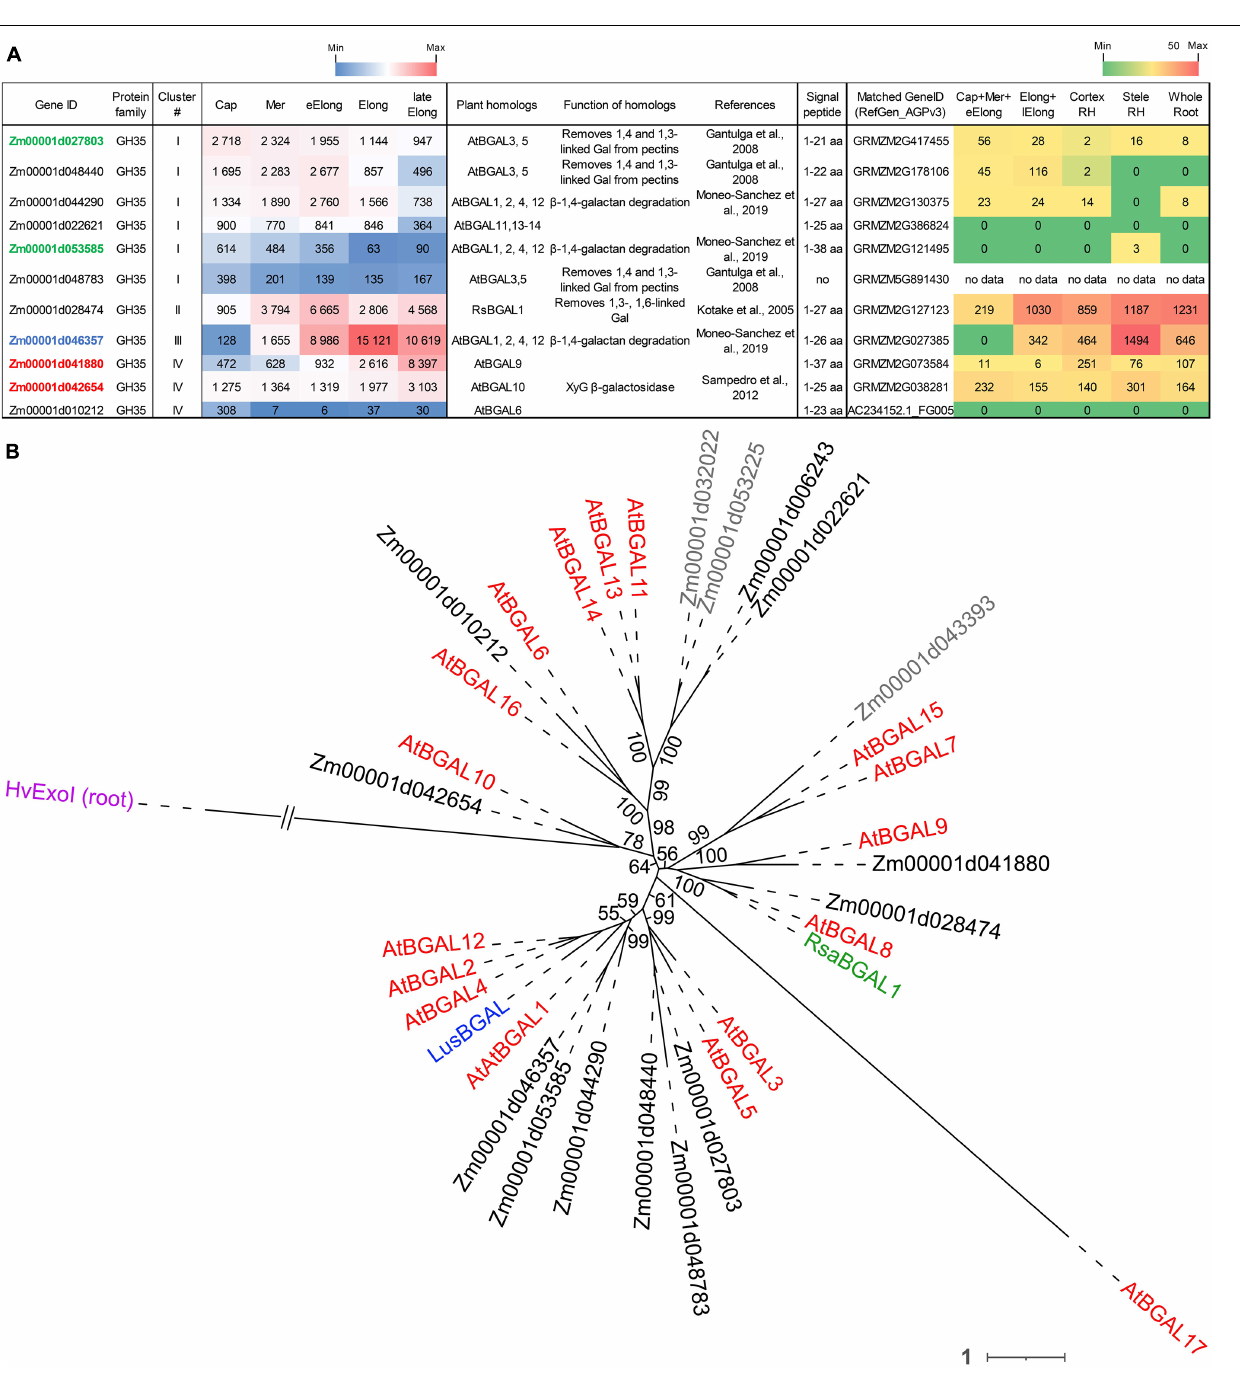
Frontiers in Plant Science |